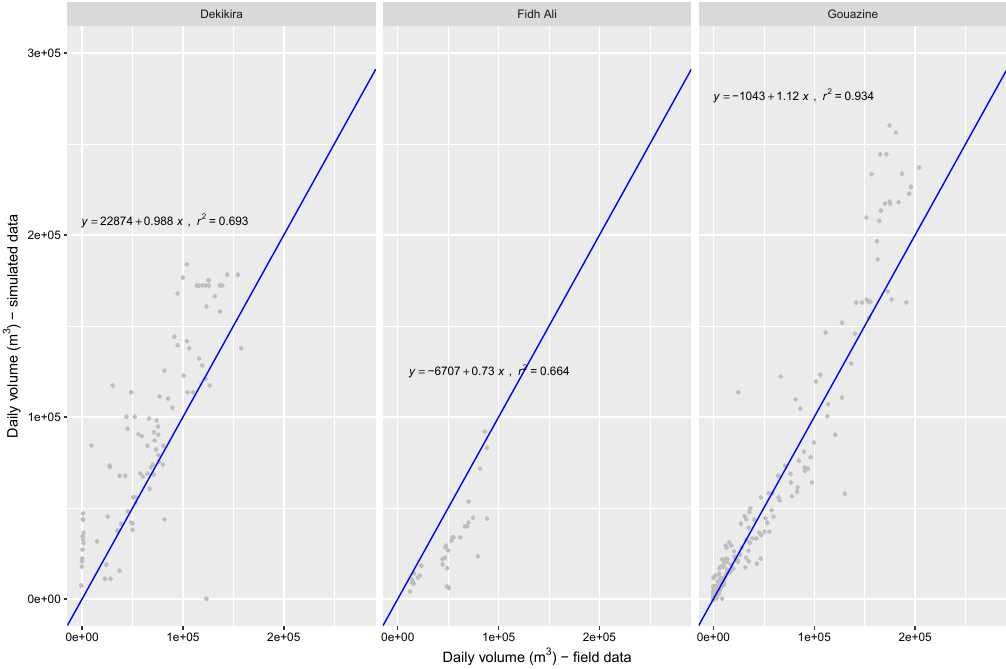
Figure 12. Correlation on daily water volumes in three lakes between field data and remotely-sensed data using the power relation adapted for silting. Table 2. RMSE and NRMSE values on daily volumes and mean annual volumes when using the site-specific surface-volume rating curves and the interSR power relation adapted for silting.